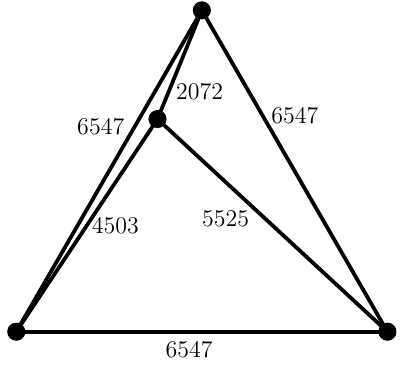
Figure 5: Equilateral triangle for t = 1 . Figure 6: Minimum d = 112 for an equilateral